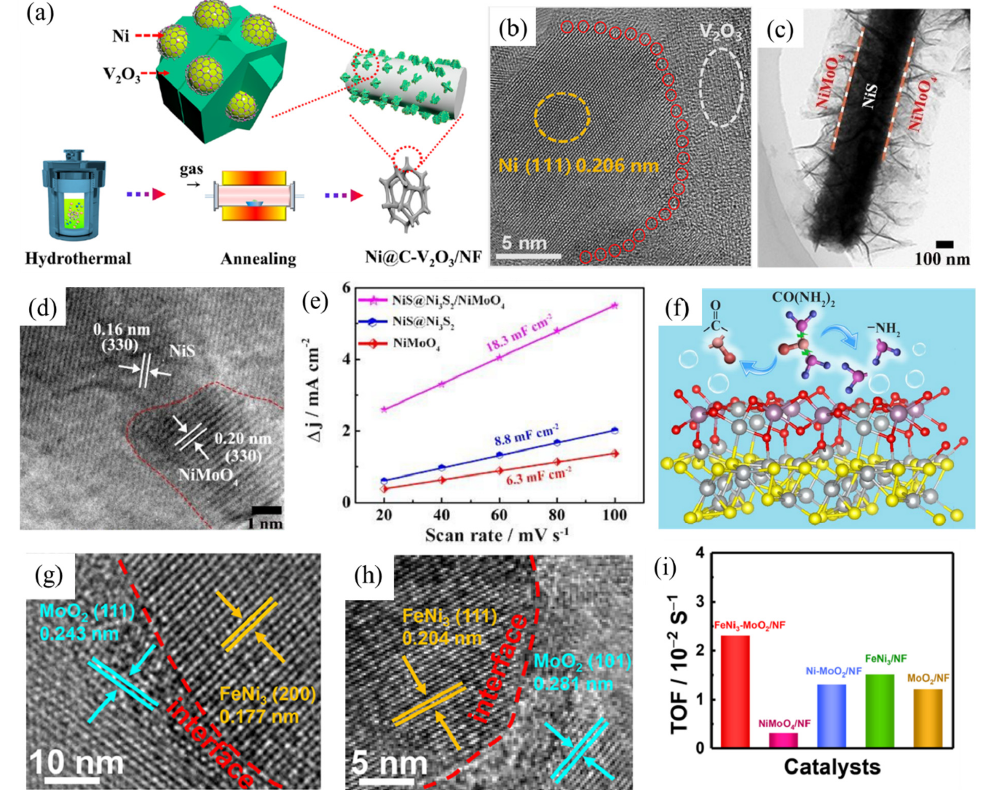
Figure 6. ( a ) Illustration of the preparations undertaken and ( b ) TEM image of Ni@C-V 2 O 3 /NF; ( c , d ) TEM images of NiS@Ni 3 S 2 /NiMoO 4 ; ( e ) evaluation of C dl values for NiS@Ni 3 S 2 /NiMoO 4 and con- trolled samples; ( f ) the proposed UOR catalytic mechanism of NiS@Ni 3 S 2 /NiMoO 4 ; ( g ) TEM images and ( i ) TOF values of FeNi 3 -MoO 2 and controlled samples. ( a , b , g – i ) Reprinted with permission from Refs. [41,45]. ( c – f ) Reprinted with permission from Ref.